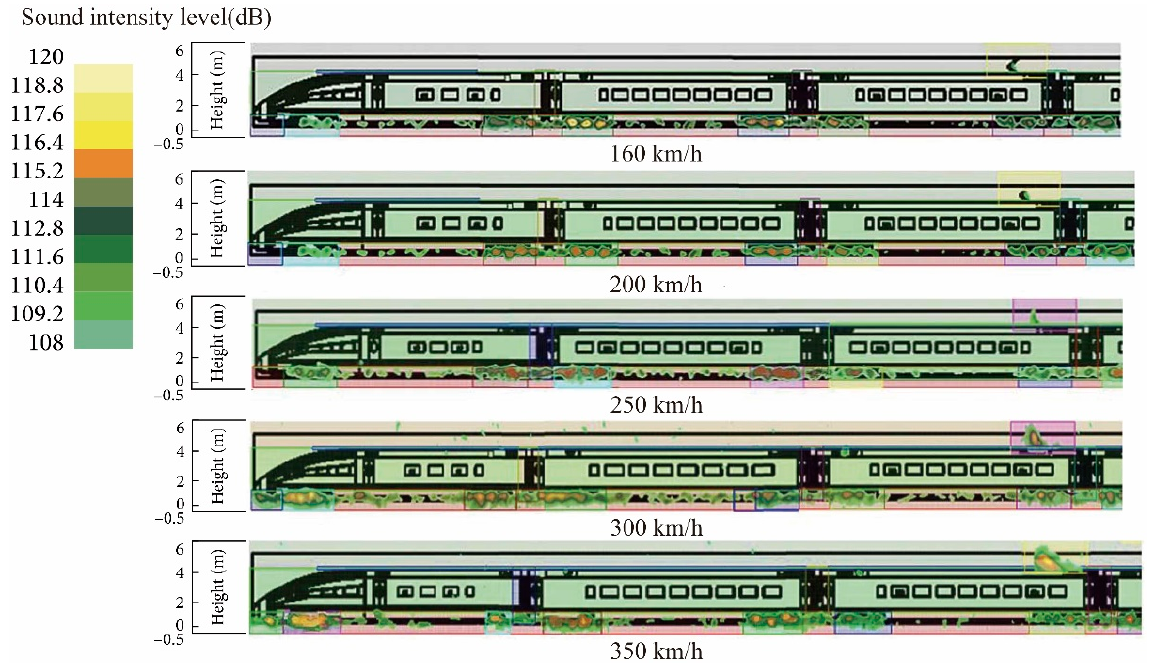
Figure 2. Noise distribution at different train speeds [48].